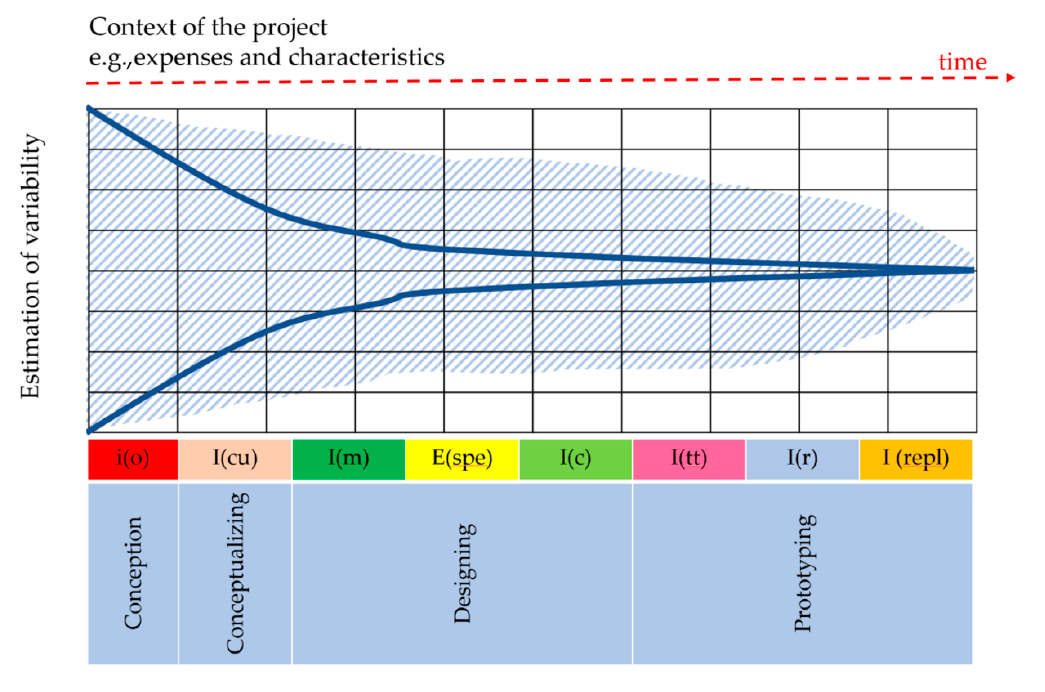
Figure 3. Development of the uncertainty phases based on the coded parameters. Table 1. Project uncertainty analysis (descriptive